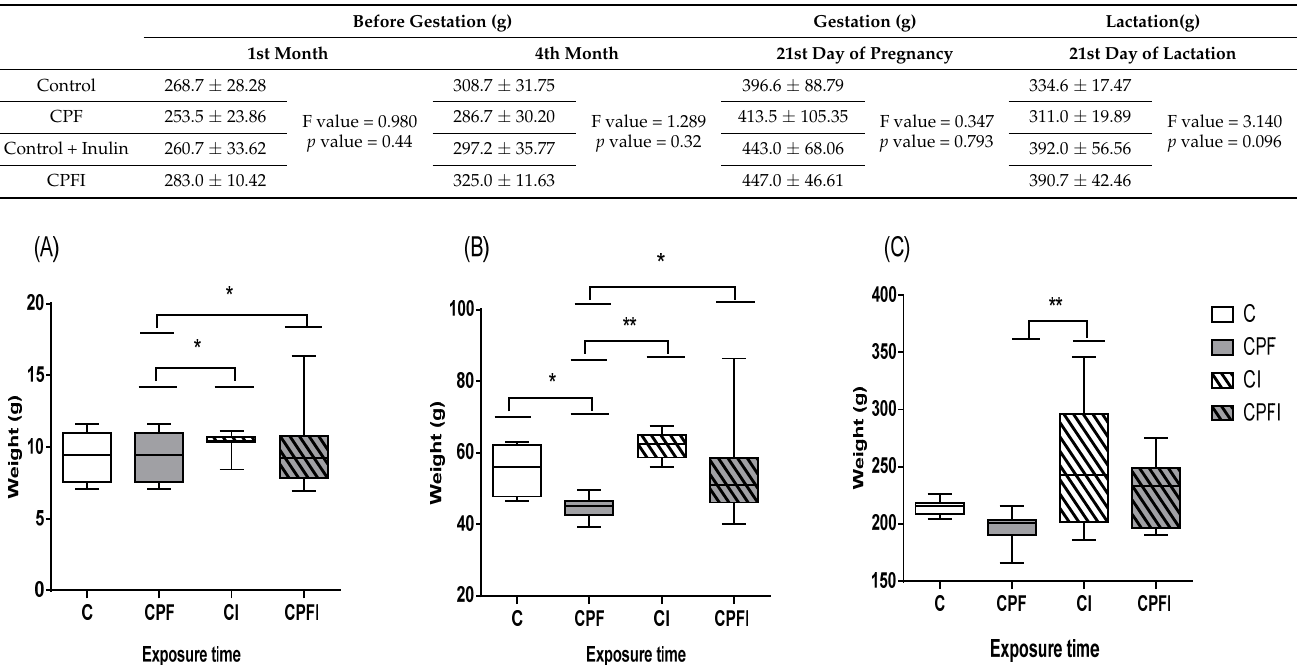
Table 1. Body weight (g) before gestation (1st month and 4th month), during gestation (21st day of gestation) and during lactation (21st day of lactation) of dams exposed to CPF and inulin. The values are expressed as mean ± SEM ( n = 4). Significantly different ( p < 0.05) using analysis of variance (ANOVA)